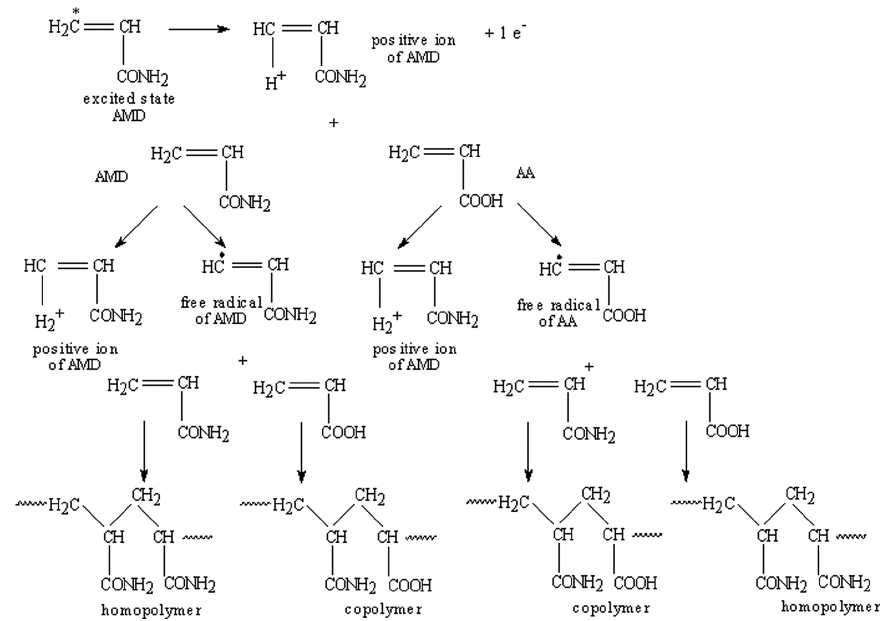
Figure 12. Possible copolymerization mechanism of acrylamide and acrylic